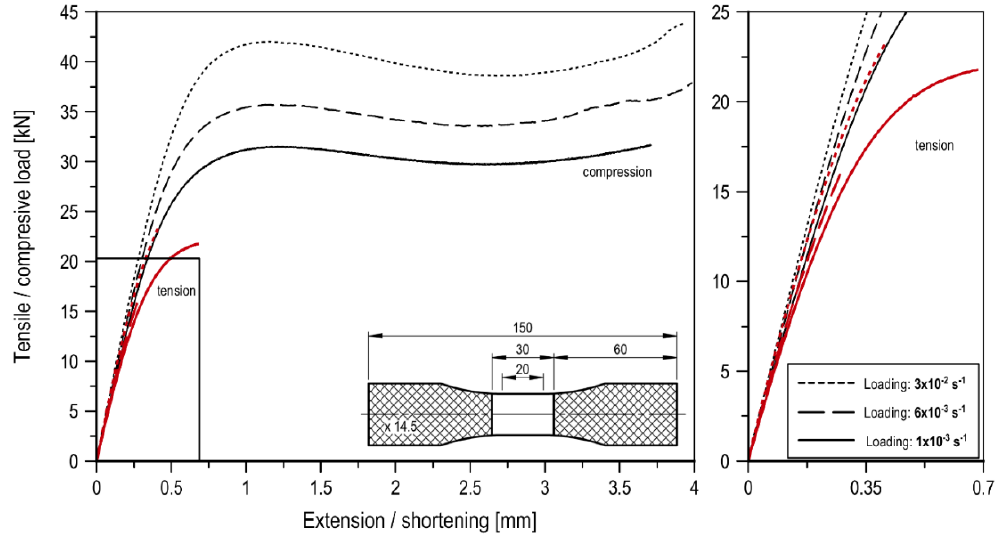
Figure 1. Tension and compression curves for the smooth specimens at different strain rates (tension, red line and compression, black line).